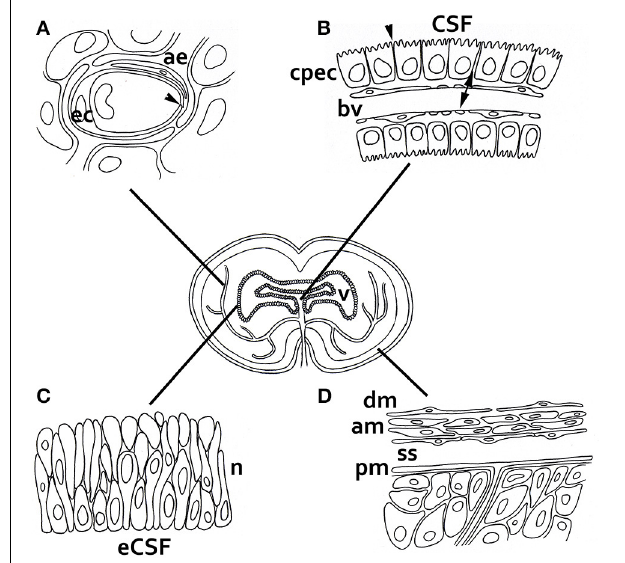
FIGURE 2 | Barriers of the developing and adult brain. (A) The blood–brain barrier between the lumen of cerebral blood vessels and the brain parenchyma. The endothelial cells have luminal tight junctions (arrowheads) that form a physical barrier, preventing the movement of molecules from the blood plasma, except those that are allowed to enter the brain via active and specific transport. In embryos, some blood vessels and the neuroectodermal cells adjacent to them also perform this function. (B) The blood–CSF barrier between choroid plexus blood vessels and the adult and fetal CSF. These blood vessels are fenestrated and form a non-restrictive barrier (arrows), but the choroid plexus epithelial cells are joined by tight junctions to stop the movement of molecules (arrowheads). (C) The inner CSF–brain barrier between the eCSF and the brain parenchyma, which is present only during early development. The neuroependymal cells lining the brain cavities do not allow the exchange of large molecules such as proteins between the eCSF and brain, but they do allow exchange of smaller molecules such as sucrose. This implies that the influence of eCSF on basic neuroepithelial cell behavior—e.g., promoting cellular survival, replication and neurogenic differentiation—has to be accounted for through specific receptors located at the apical pole of neural progenitor cells, which are in contact with the lumen of the cavities. There is no crossing restriction in the adult brain. (D) The outer CSF–brain barrier between the subarachnoid space and overlaying structures. The blood vessels are fenestrated, but the outer cells of the arachnoid membrane are connected by tight junctions. Abbreviations: ae, astrocitic endfoot; am, arachnoid membrane; bv, blood vessel; cpec, choroid plexus endothelial cell; dm, dura mater; ec, endothelial cell; n, neuroepithelium; pm, pia mater; ss, subarachnoid space; v,